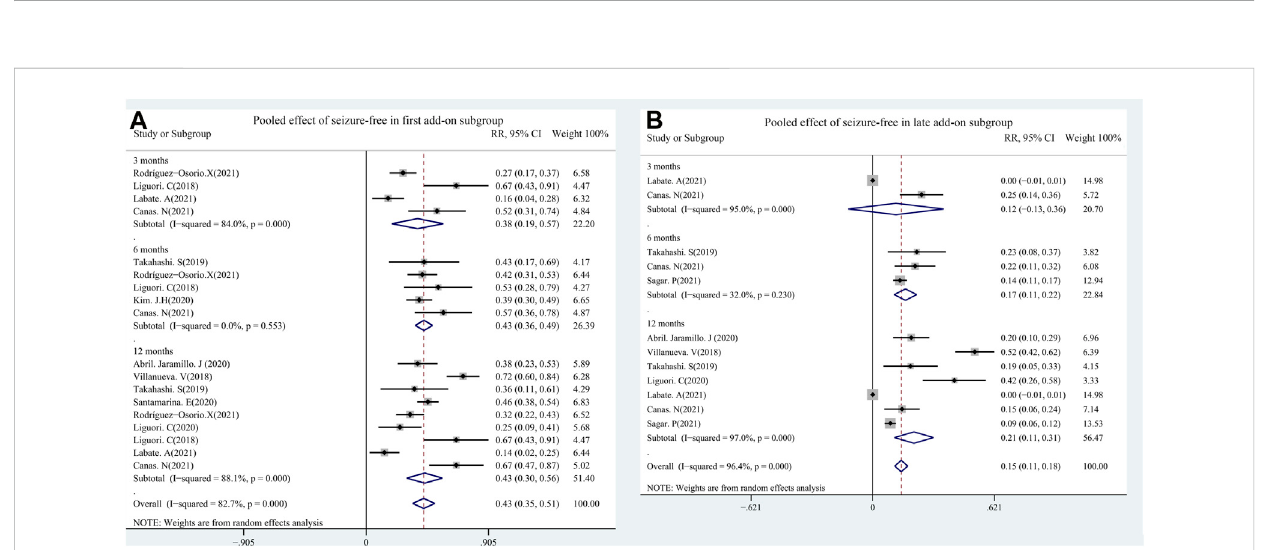
FIGURE 7 First (A) vs . late add-on (B) : seizure-free rate by follow-up points (3, 6, and 12 months after PER treatment.